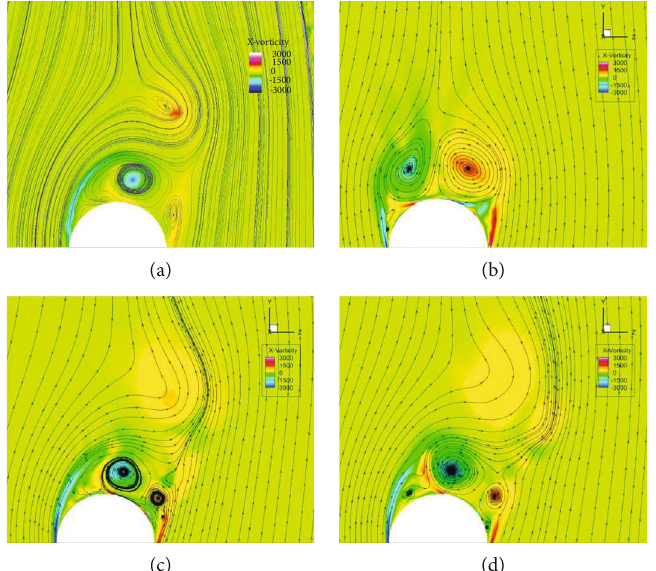
Figure 12: X -vorticity contour comparison at section 4: (a) PIV experiment, (b) result of Grid 1, (c) result of Grid 2, and (d) result of Grid